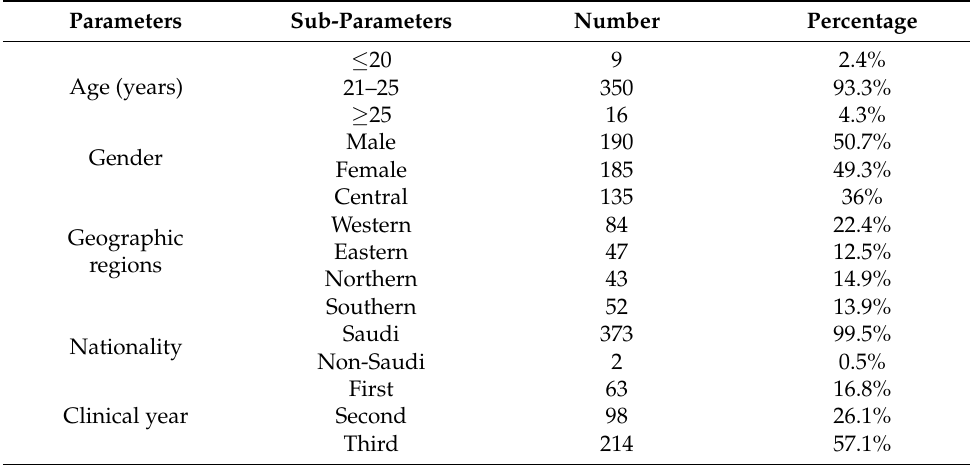
Table 1. Demographic details of study participants.